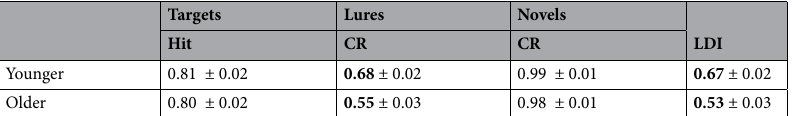
Table 2. Accuracy and Discrimination in Experiment 1. Summary statistics show the accuracy of responses for targets, lures and novels in the MDT for groups of younger and older adults in Experiment 1, as well as the calculated LDI for each group (i.e., proportion Lure correct rejections—proportion novel false alarms). CR indicates correct rejection. Values in bold face indicate differences between groups in that measure, p <